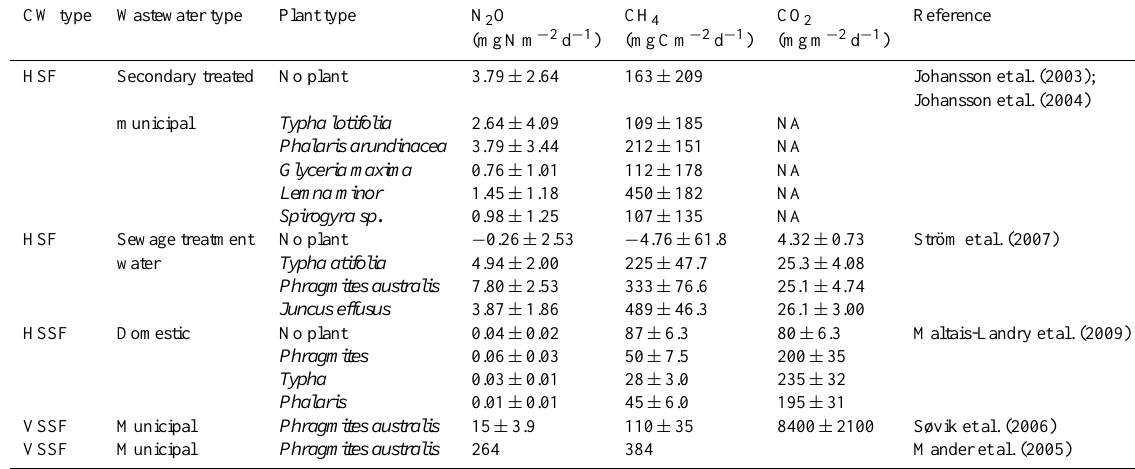
Table 5. Nitrous oxide (N 2 O; mg N m − 2 d − 1 ), CO 2 , and CH 4 emissions (mgCm − 2 d − 1 ) in various type of CWs under different plant types; NA – data not